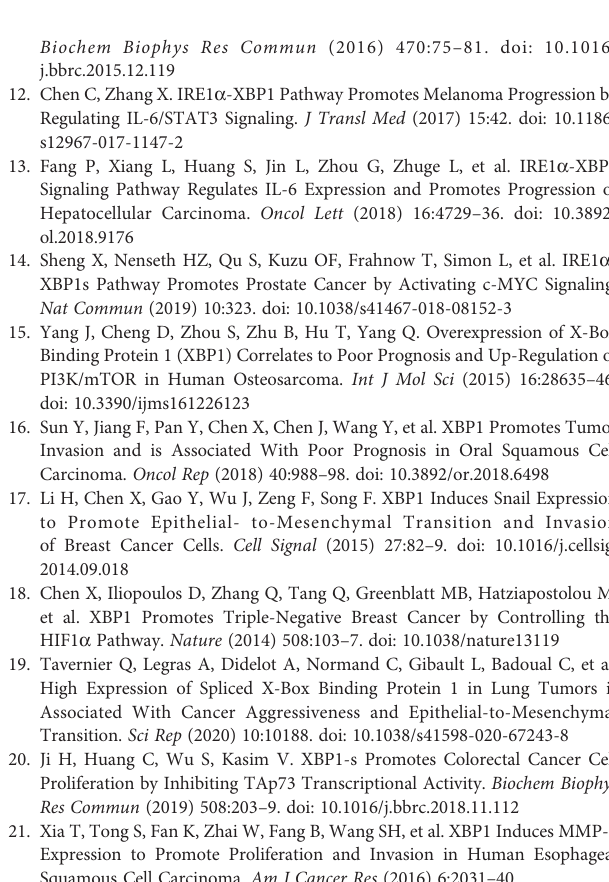
Supplementary Figure 1 | The expression of the selected 7 genes (IGFBP3, USP47, SEC24D, PYCR1, MANF, FKBP2, DNAJB2) in NSCLC to the normal lung tissues by analyzing available ONCOMINE